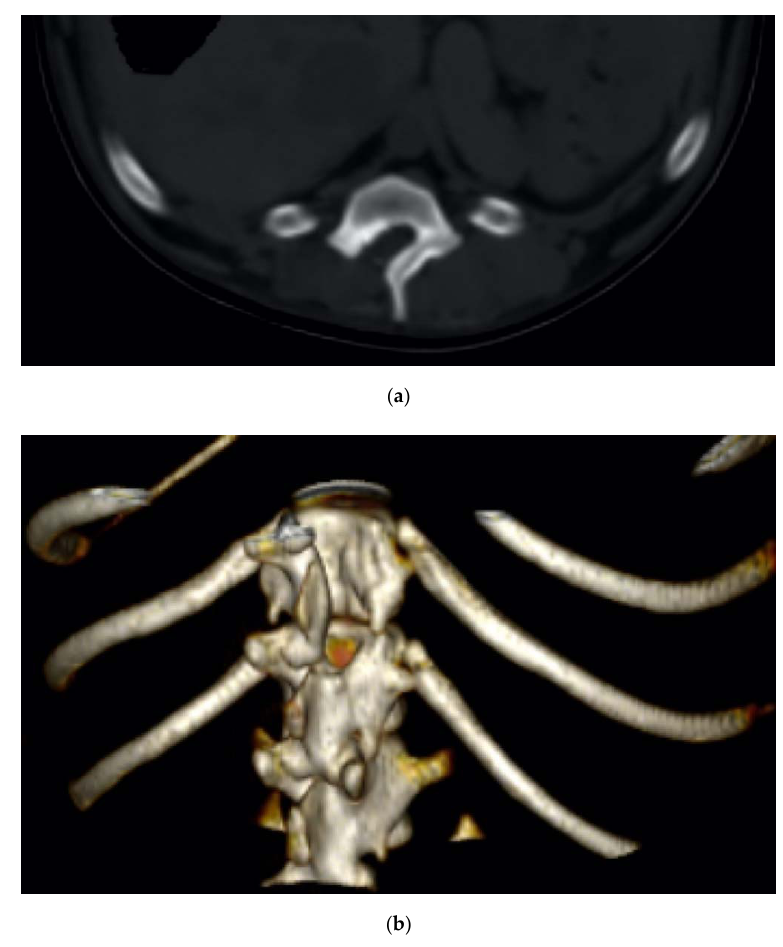
Figure 9. Two-dimensional ( a ) and 3D ( b ) CT scan of an explicative case of dorsal hemilaminectomy performed in a dachshund diagnosed with a spinal cord